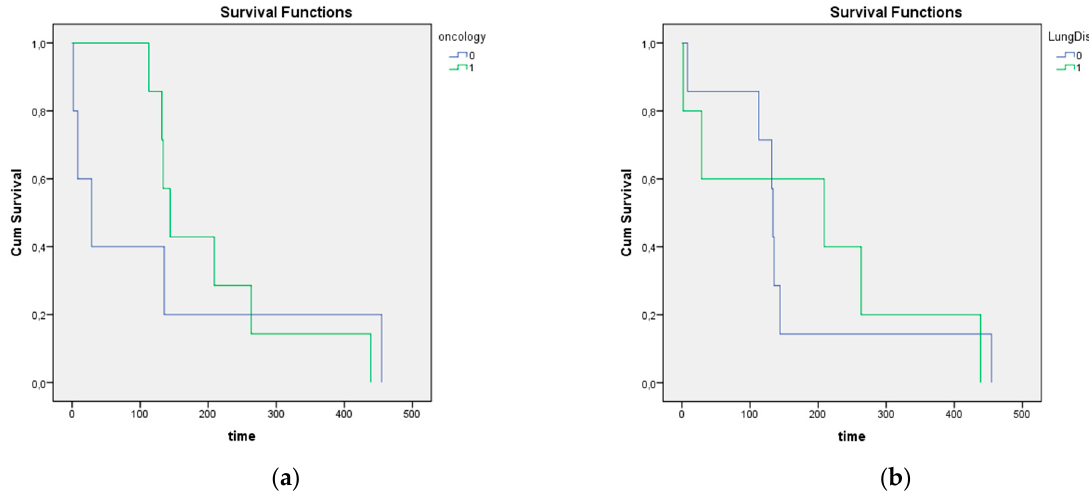
Figure 3. Kaplan–Meier survival analysis of survival time in patients suffering from oncologic disease ( a ) or pulmonary disease ( b ). We did not find any significant differences in survival time.